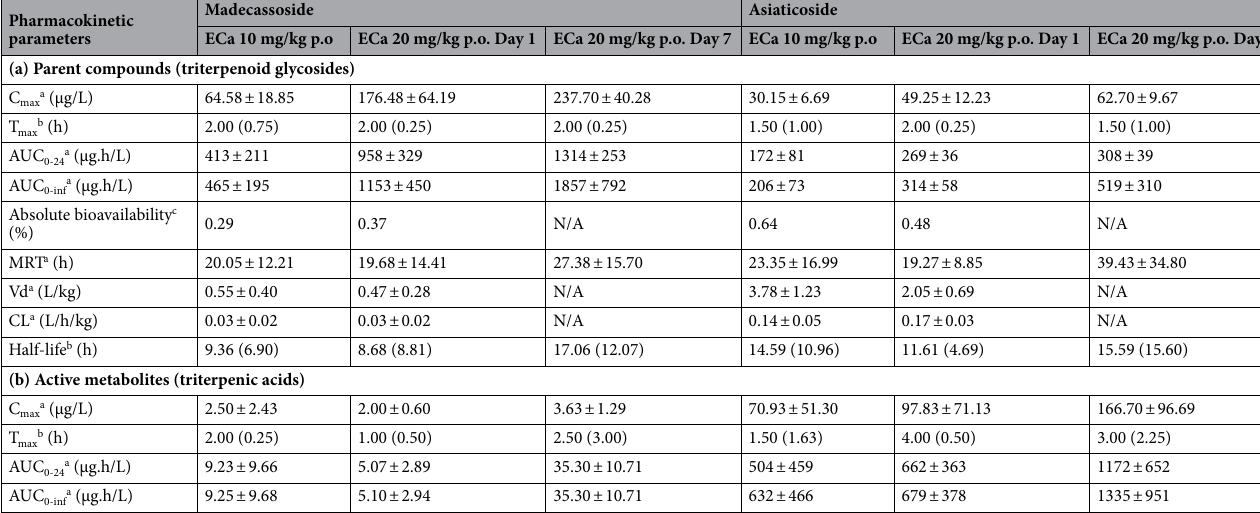
Table 3. Pharmacokinetic parameters of madecassoside and asiaticoside (a) and madecassic acid and asiatic acid (b) after oral administration of 10 and 20 mg/kg ECa 233 as a single dose or repeated doses. C